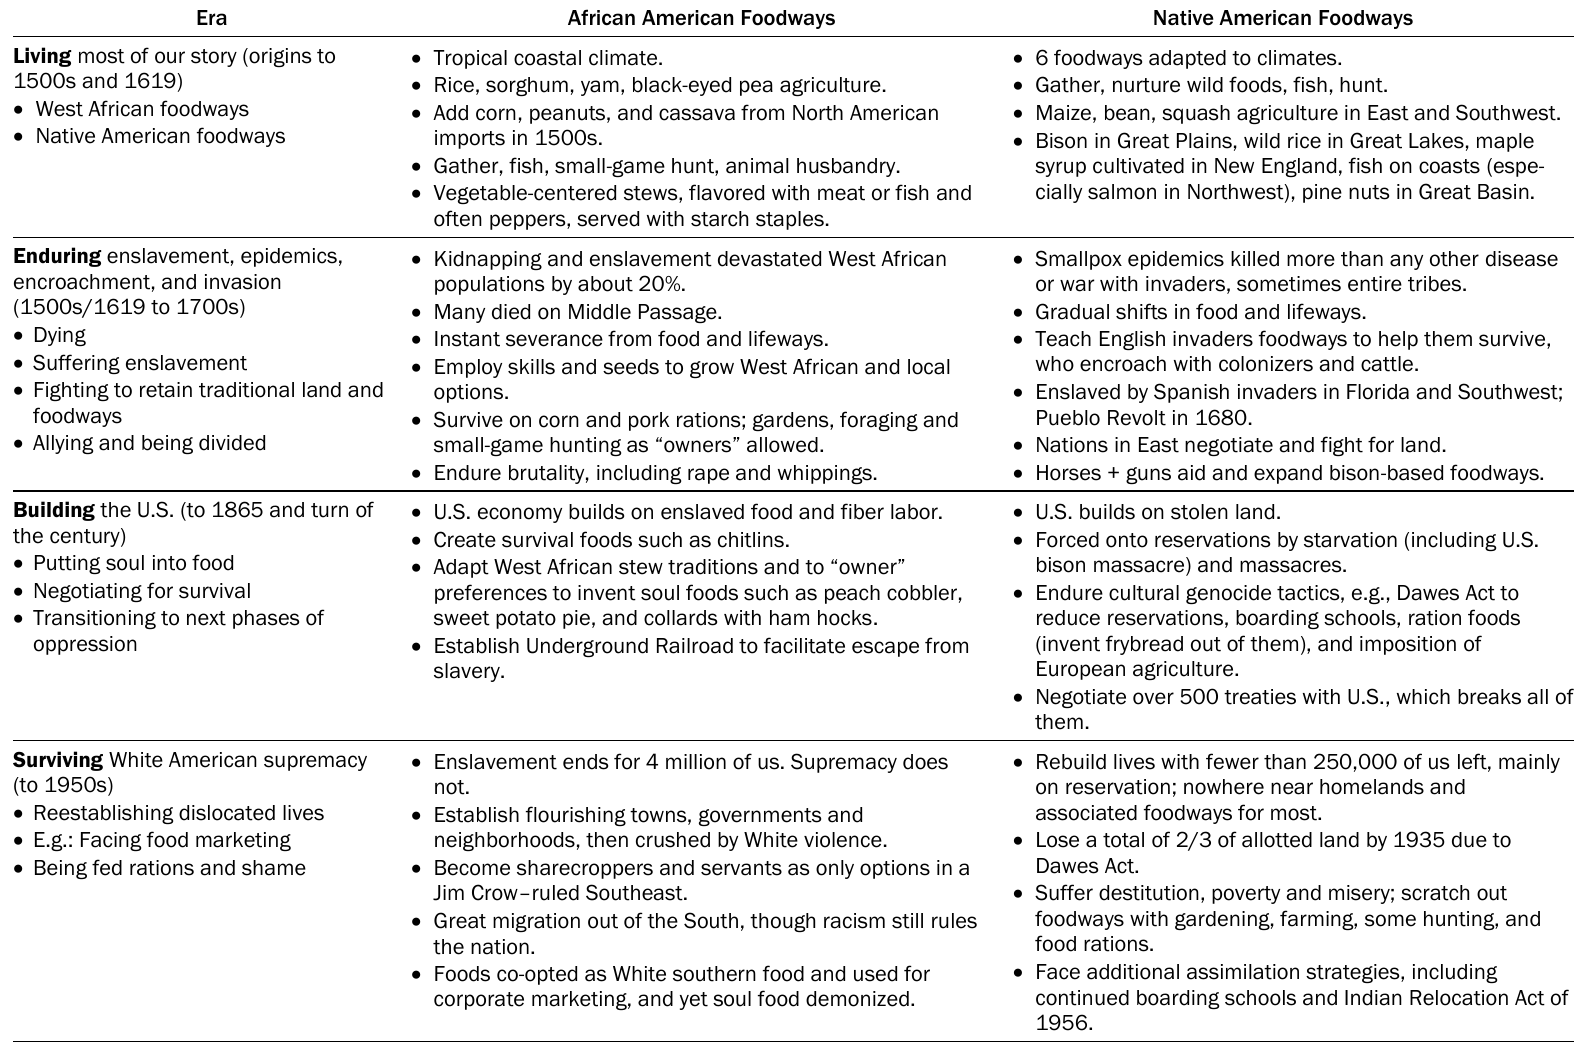
Table 1. Summary of Key Eras in African American and Native American Foodways, 1500s – 2020